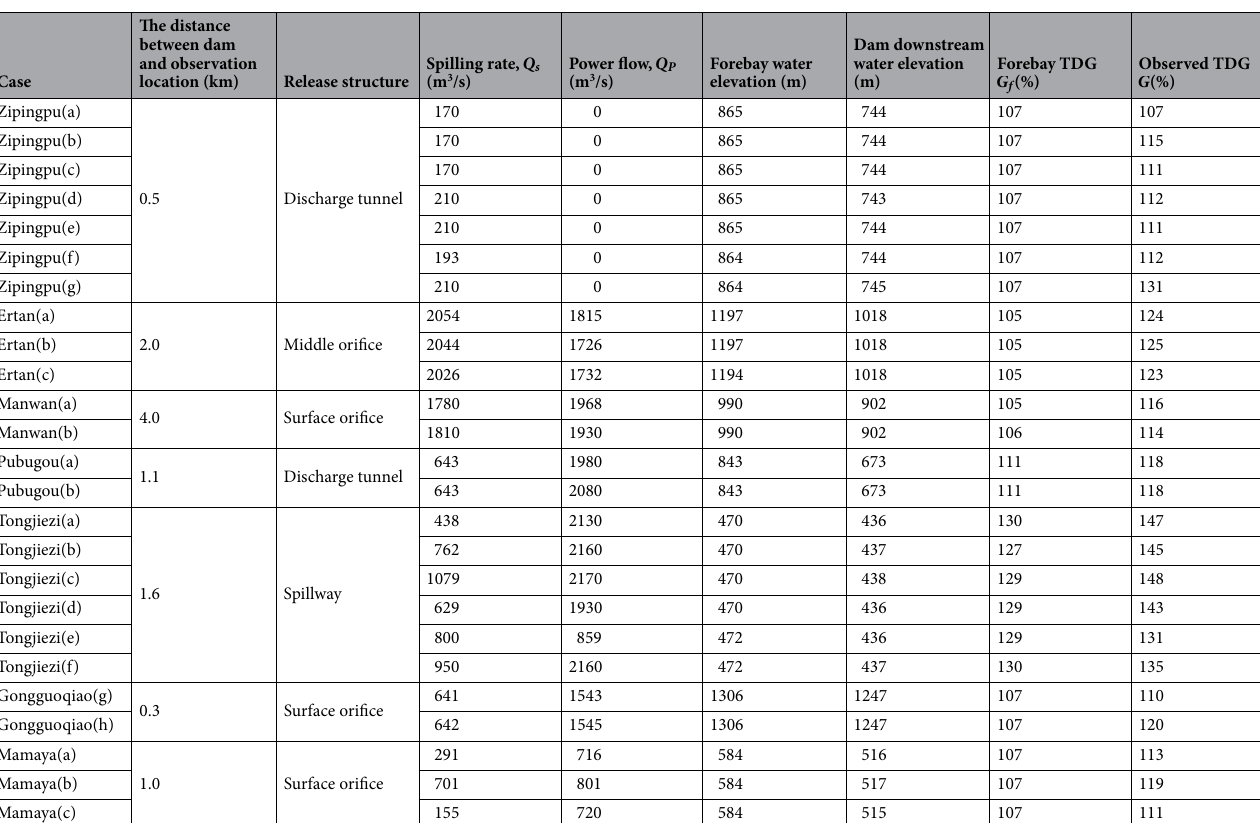
Table 2. TDG measurements in other multiple